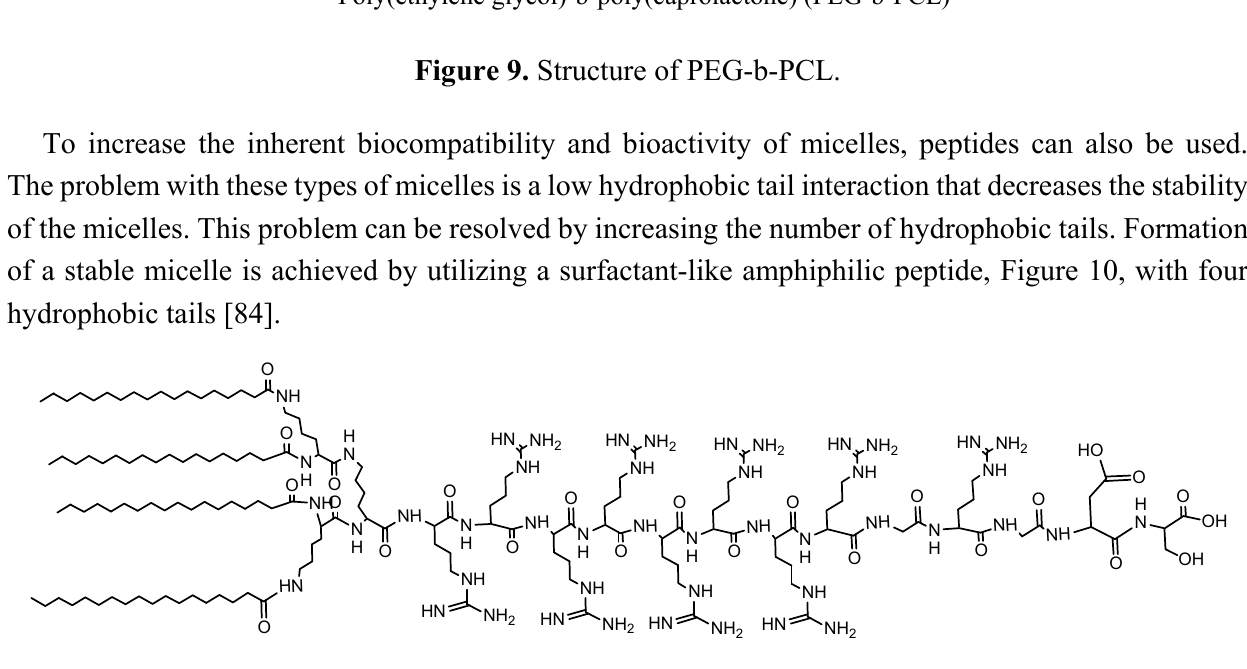
Figure 9. Structure of PEG-b-PCL.